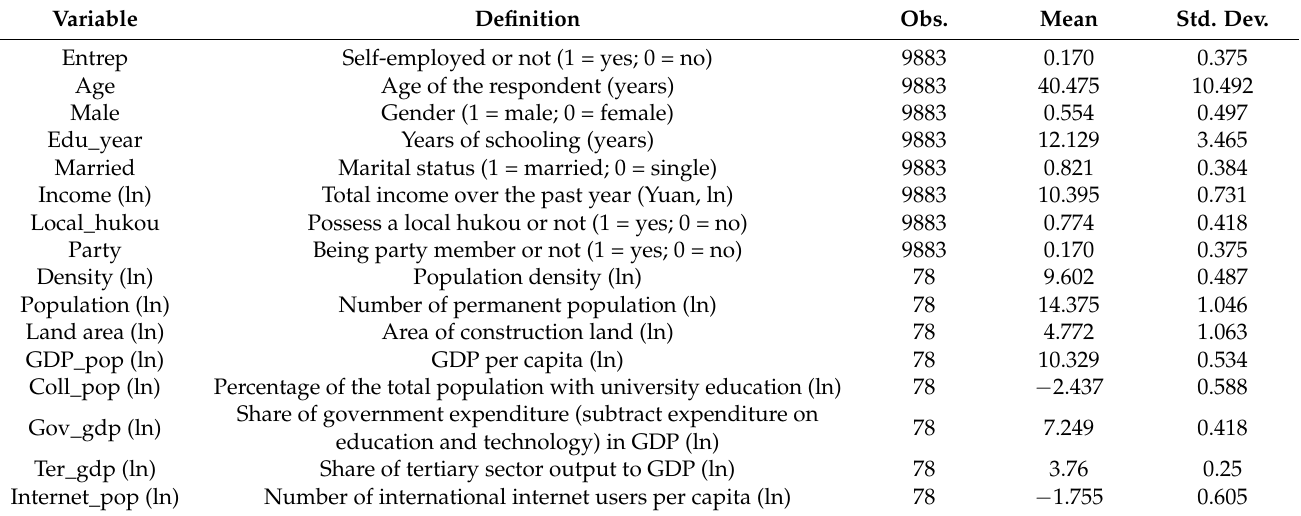
Table 2. Variable definitions and summary